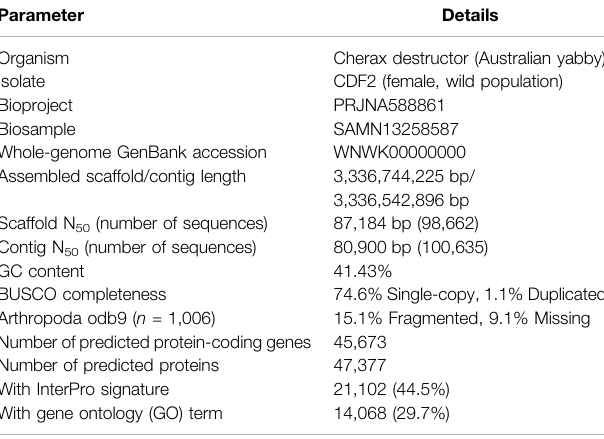
TABLE 1 | Genome assembly and annotation